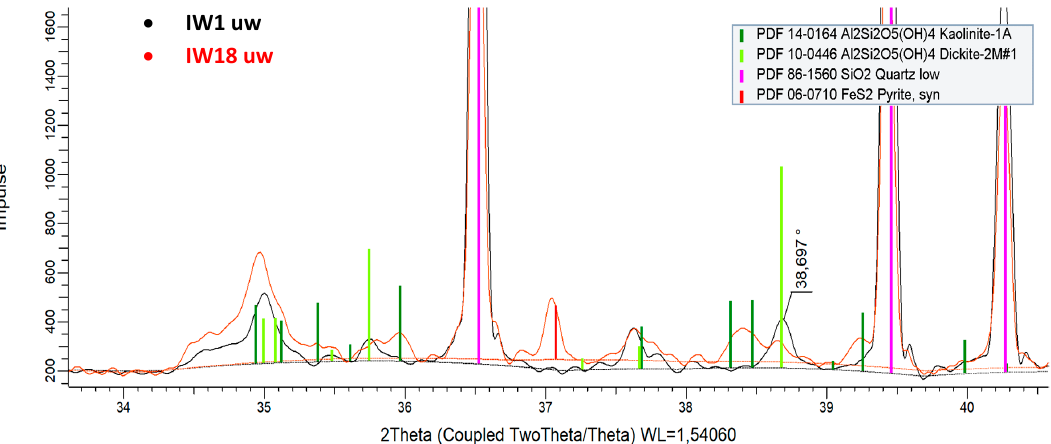
Figure 6. Diagnostic peaks of quartz, pyrite, kaolinite and dickite for samples IW1 uw and IW18 uw.